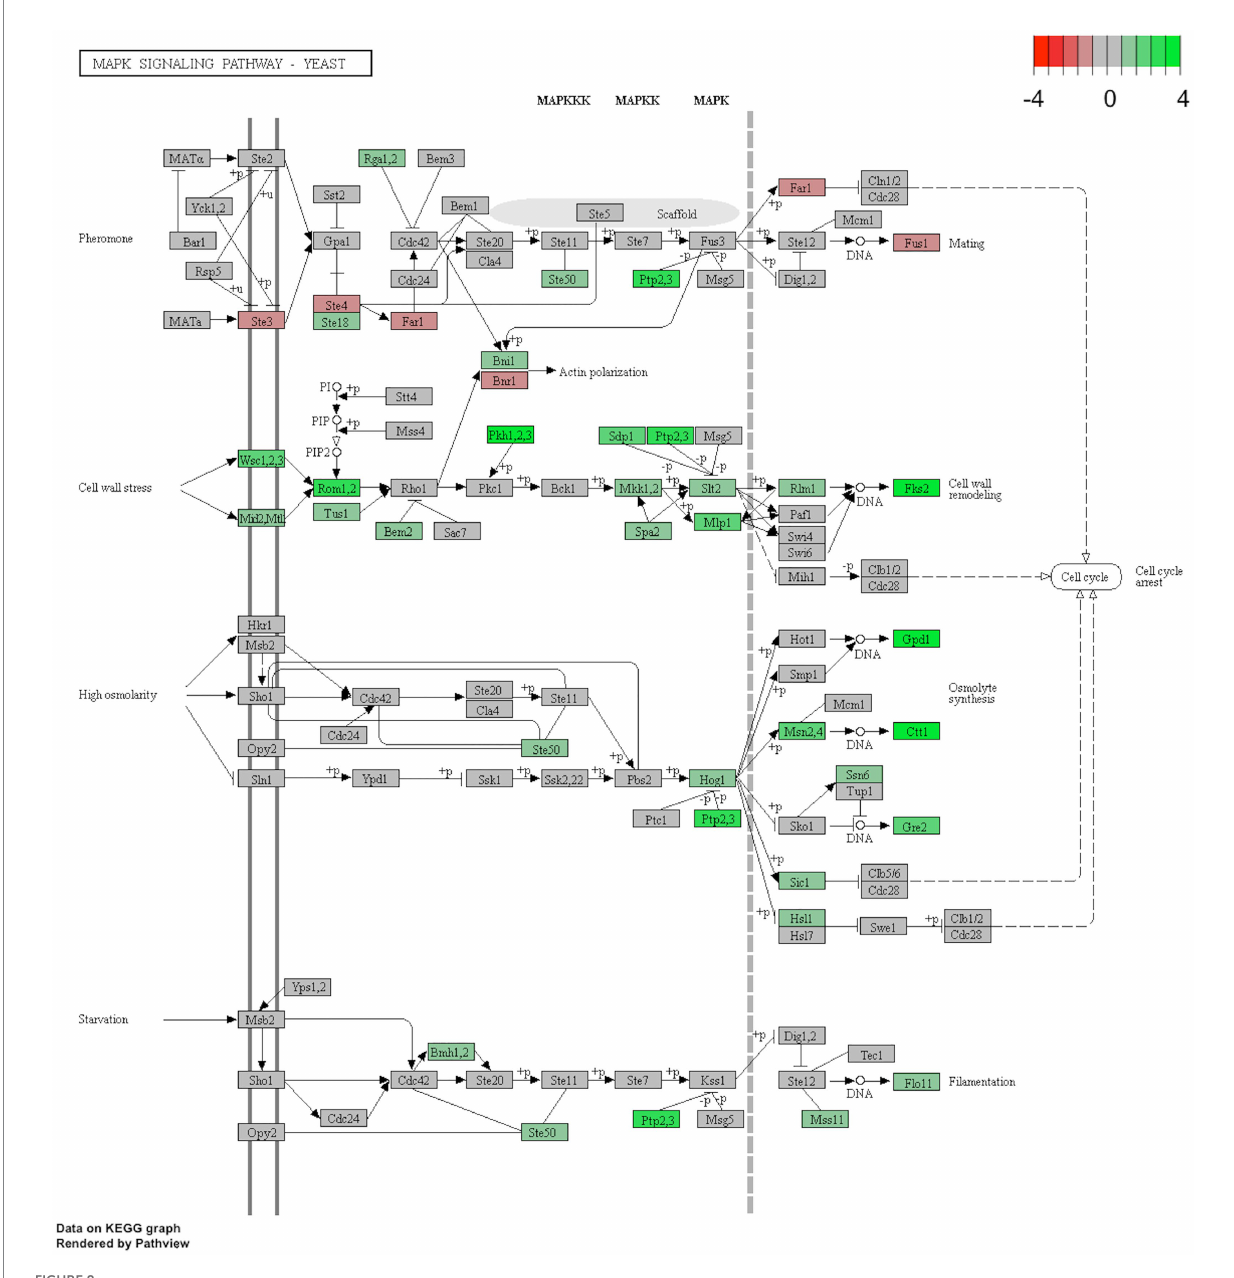
FIGURE 8 KEGG pathway of the MAPK Signalling Pathway (sce04011) that belongs to the 2-phenylethanol-resistant strain C9. Red boxes show the genes that were downregulated, while the green boxes show the upregulated